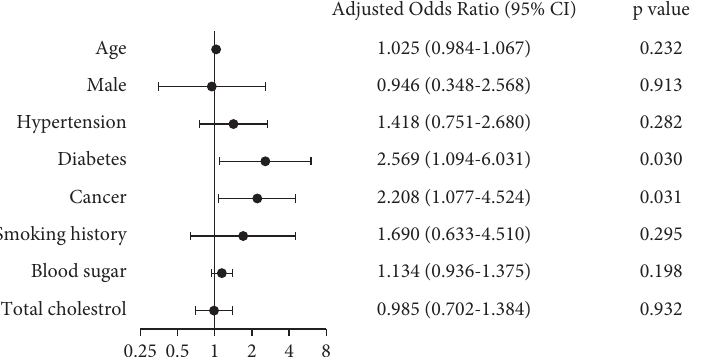
Figure 3: Forest plot of the multivariable logistic regression model. Cancer is significantly associated with high Gensini score (adjusted OR � 2.208, 95% CI: 1.077–4.524, p � 0 . 031). CI indicates confidential